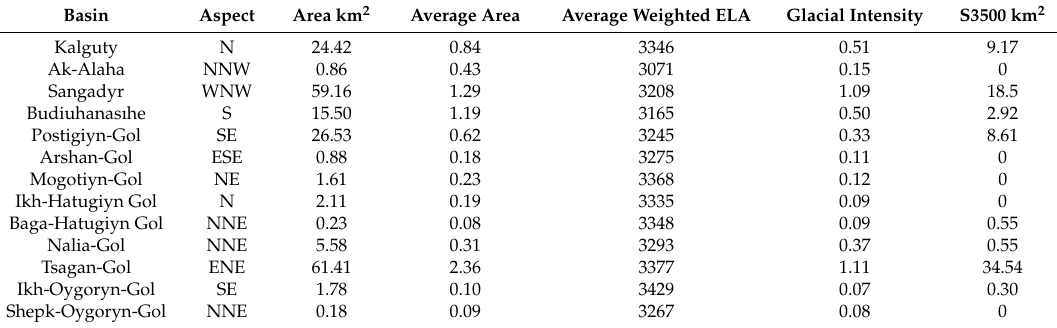
Table 3. Glacio-geomorphologic features of different river basins of Tavan-Bogd.